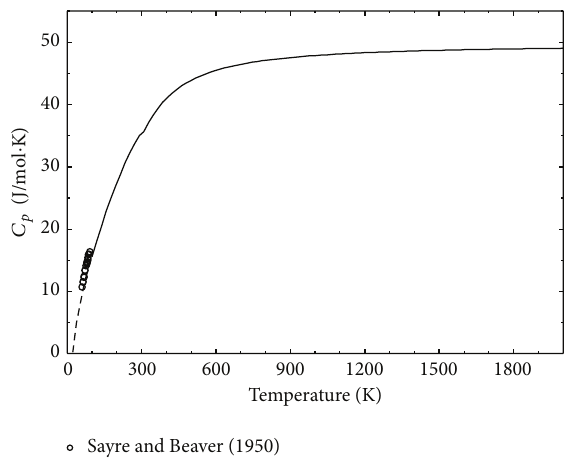
Figure 8: Calculated heat capacity 𝑐 𝑝 of NaH in comparison with experimental data